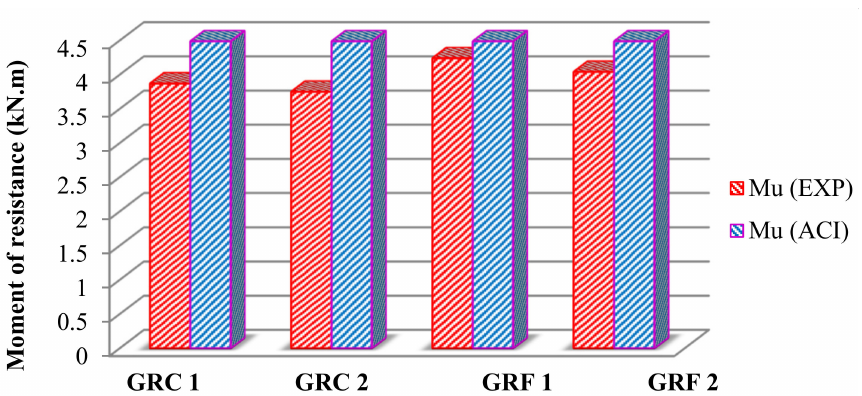
Figure 15. Moment of resistance of GFRP